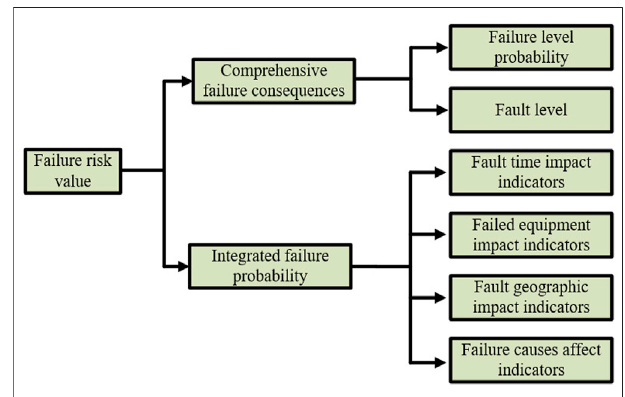
FIGURE 1 | Fault risk indicator system framework